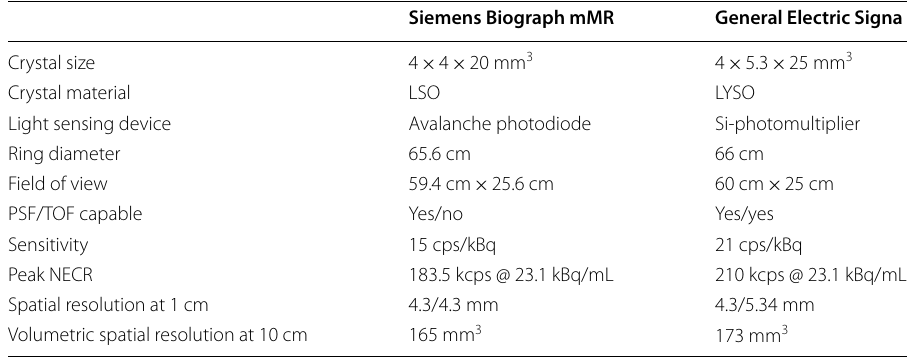
Table 1 Compilation of representative scanner